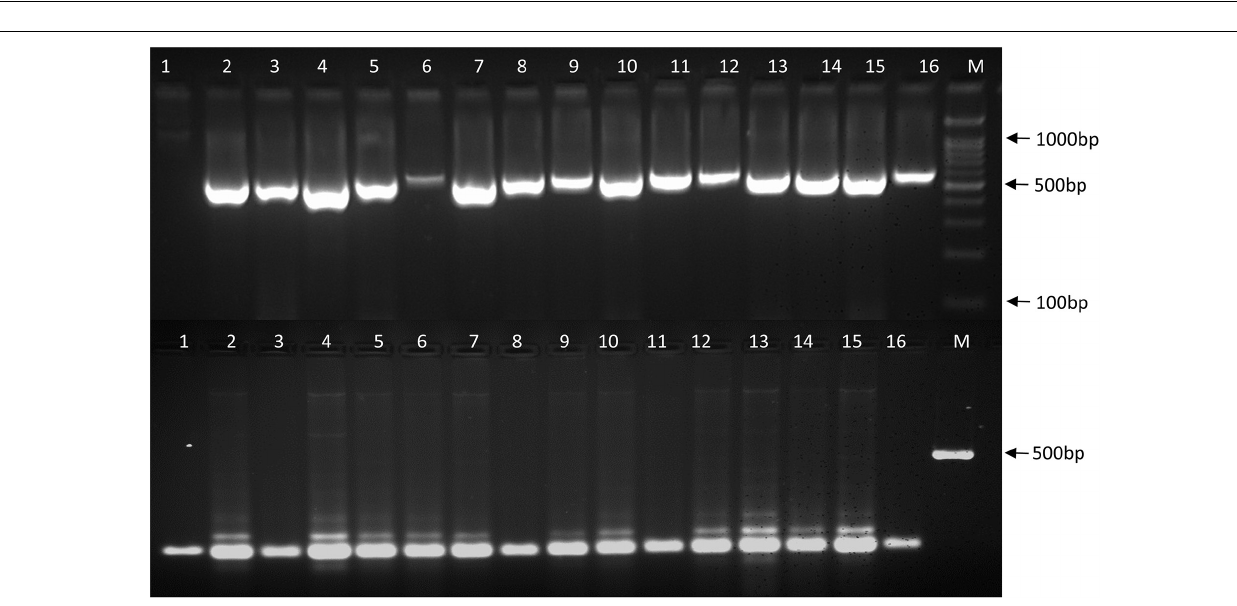
FIGURE 9 | Amplification profiles of 16 urdbean genotypes using SSR primers (DR04 and YMVSSR74). The numbers represent the genotypes 1: UPU-85-86; 2: IPU94-2; 3: IPU-98/36; 4: NO. 5/31; 5: PGRU-95014; 6: PGRU-95016; 7: PLU-1, 8: BGP-247; 9: IPU99-200; 10: IC-21001; 11: SEKHAR-2; 12: UTTARA; 13: PU-19; 14: HPU-120; 15: H-1; 16: PKGU-1; M: DNA